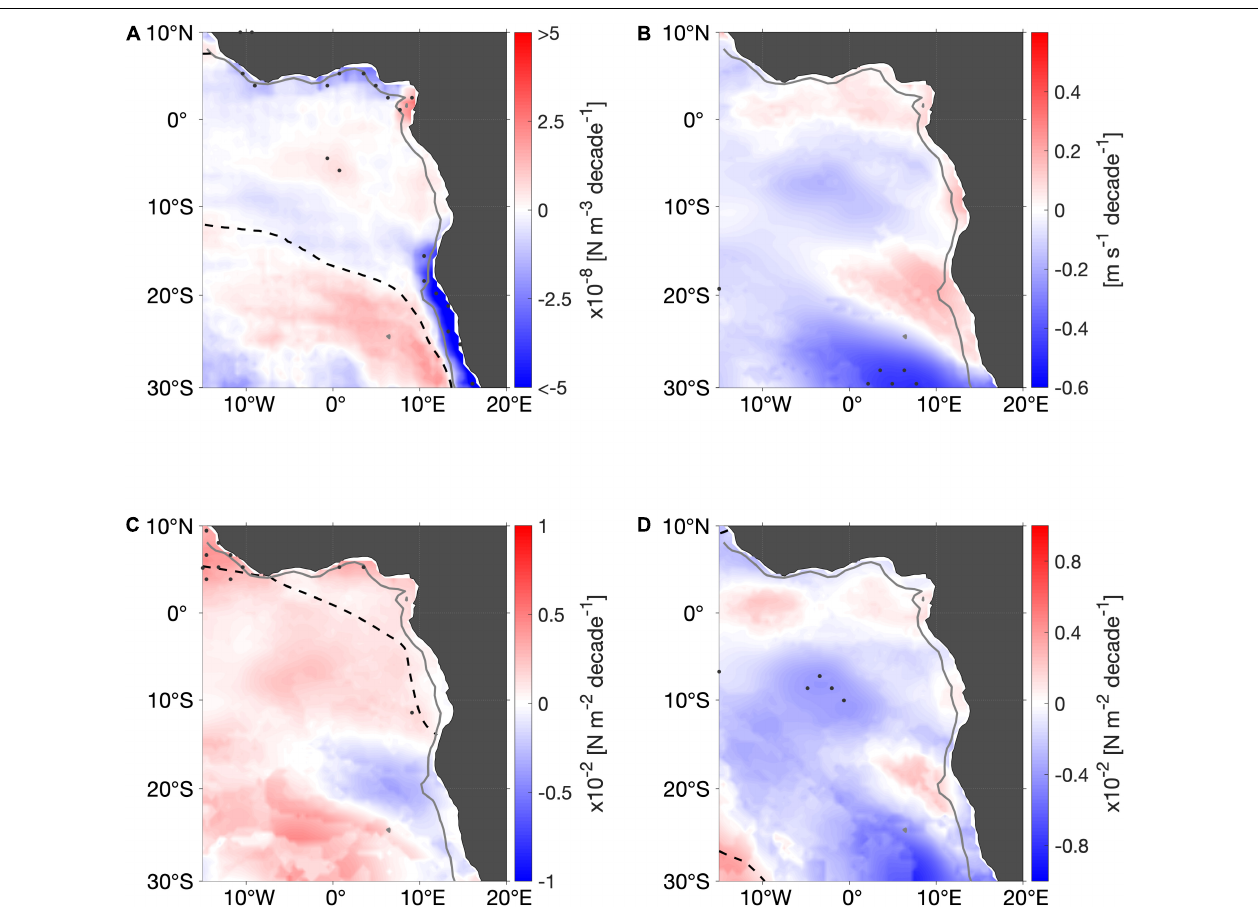
FIGURE 10 | Decadal trend of (A) wind stress curl, (B) wind speed, (C) zonal wind stress component, and (D) meridional wind stress component from monthly values from Copernicus Marine environment monitoring service (CMEMS) from ASCAT scatterometers on METOP-A and METOP-B satellites for the time period of 2007–2019. Trends are computed from the anomaly relative to the monthly mean. Black dashed lines indicate the zero-lines of the corresponding mean fields, respectively. Areas where the trend is of 95% significance are stippled. Gray line marks the 2,000 dbar isobath of the shelf